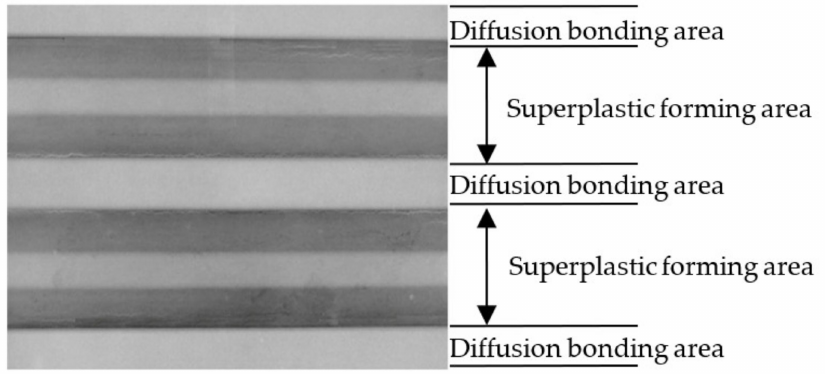
Figure 6. Two-sheet hollow structure of the 1420 Al-Li alloy.